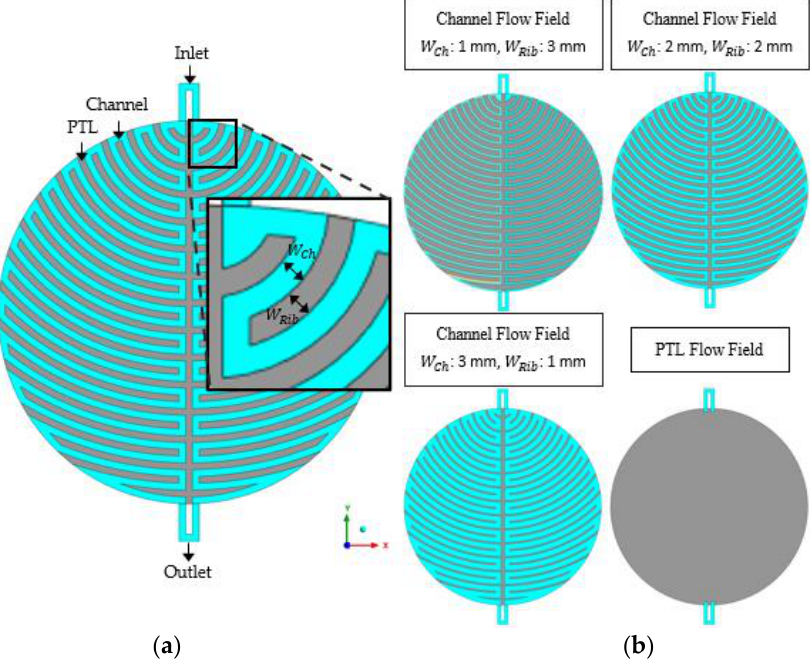
Figure 1. Schematic of the PEMWE and computational fluid domain used for this study.